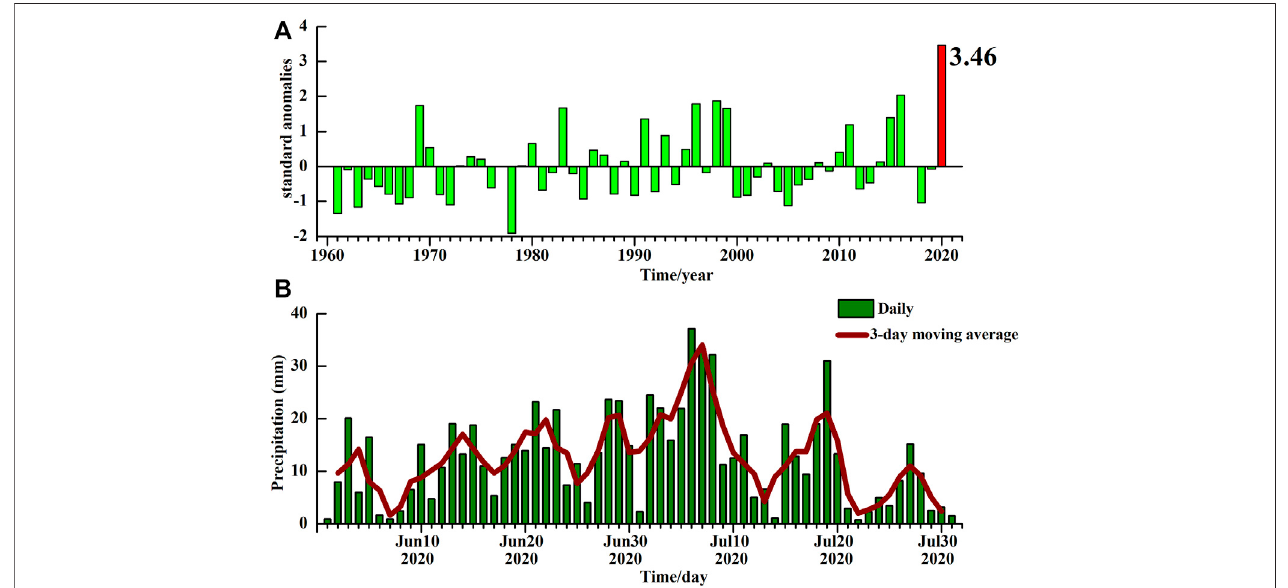
FIGURE1|(A) InterannualvariationsofstandardizedanomaliesoftotalprecipitationofJune – Julyaveragedat277observationstationsoverMeiyumonitoringarea in China from 1961 to 2020. Value in 2020 is labeled. (B) Daily (bars) and 3-day moving mean (curve) precipitation averaged at 277 observation stations over Meiyu